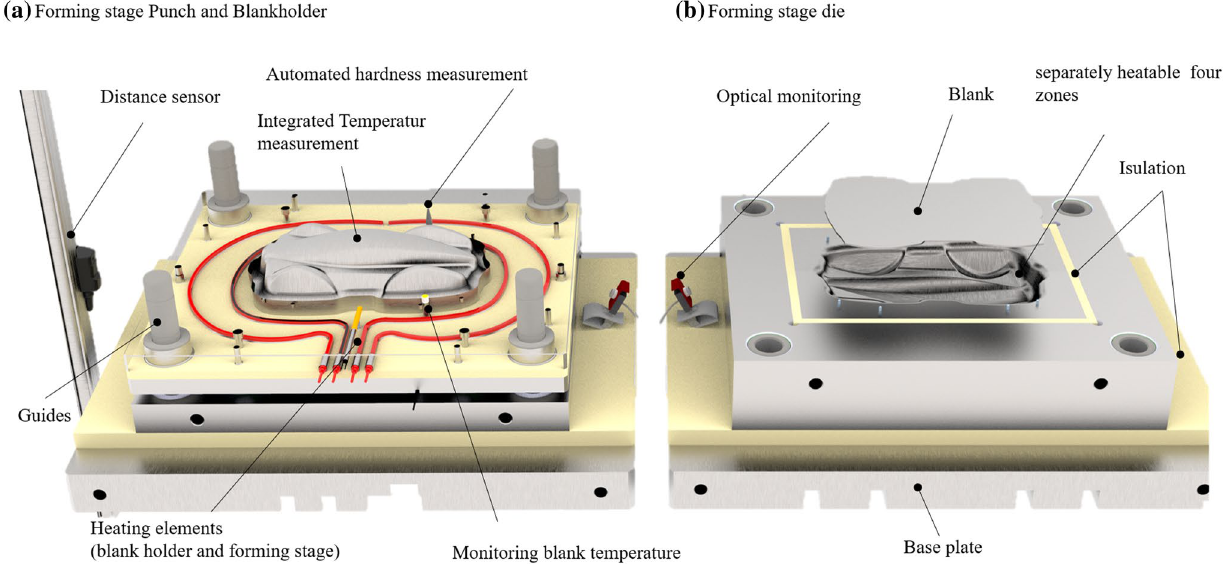
Fig. 2 Design of the smart forming tool including temperature sensors and intelligent heating zones, with a Forming stage punch and blank holder; b Forming stage